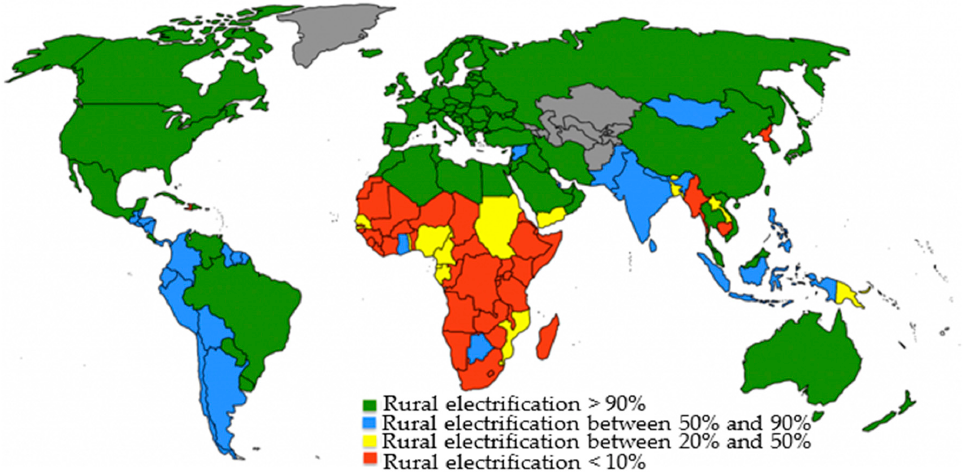
Figure 2. Electrification progress in rural areas around the world [10].